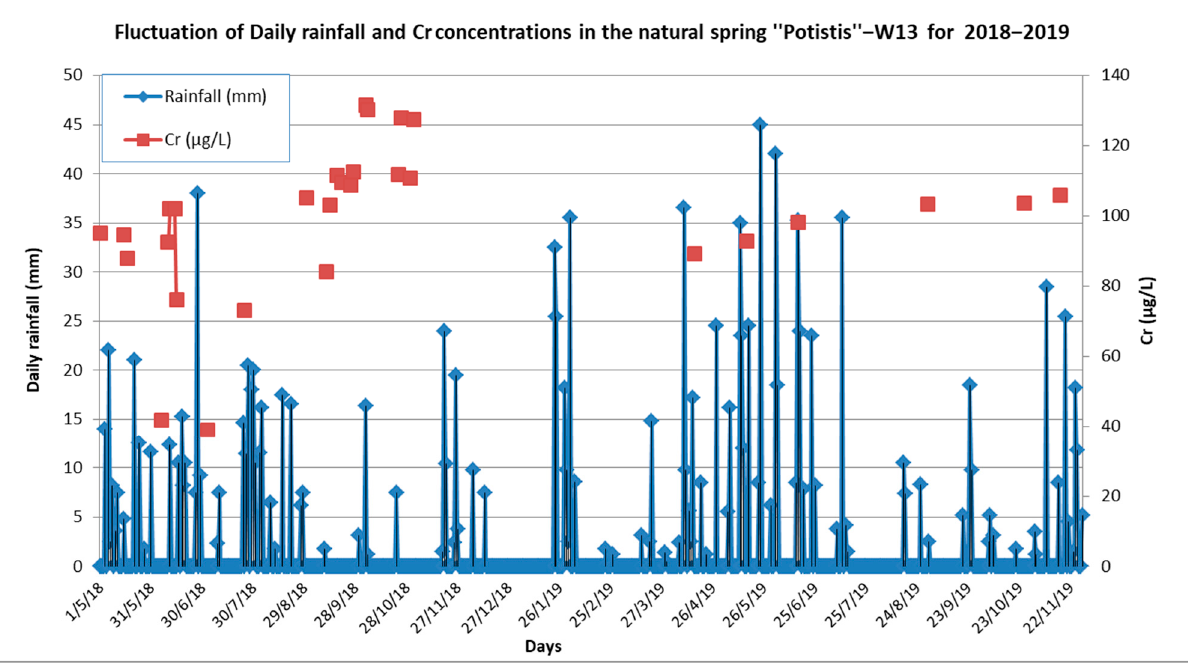
Figure 16. Fluctuation diagrams of rainfall and Cr concentrations of the natural spring “Potistis”-W13 in western Vermio